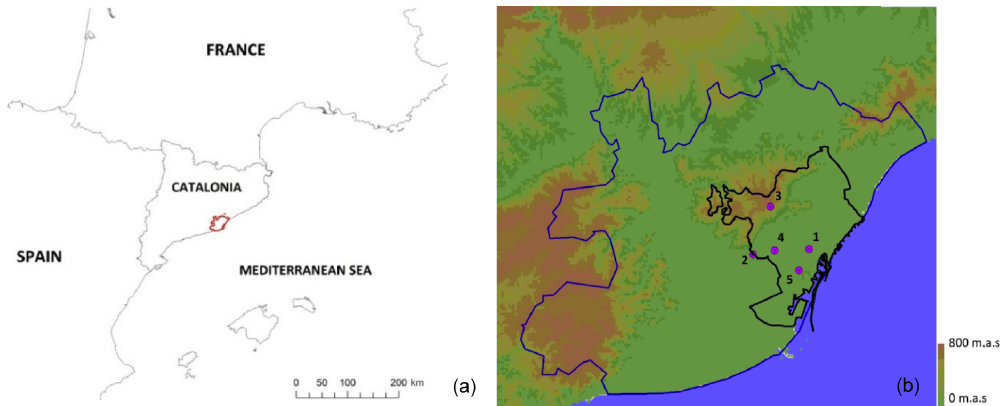
Figure 1. (a) Location of the Metropolitan Area of Barcelona (AMB), (b) Domain used to run the UrbClim model. The blue line marks the border of the AMB, while the black line shows the municipality of Barcelona. The numbers indicate the weather stations used to assess the LCZ– T